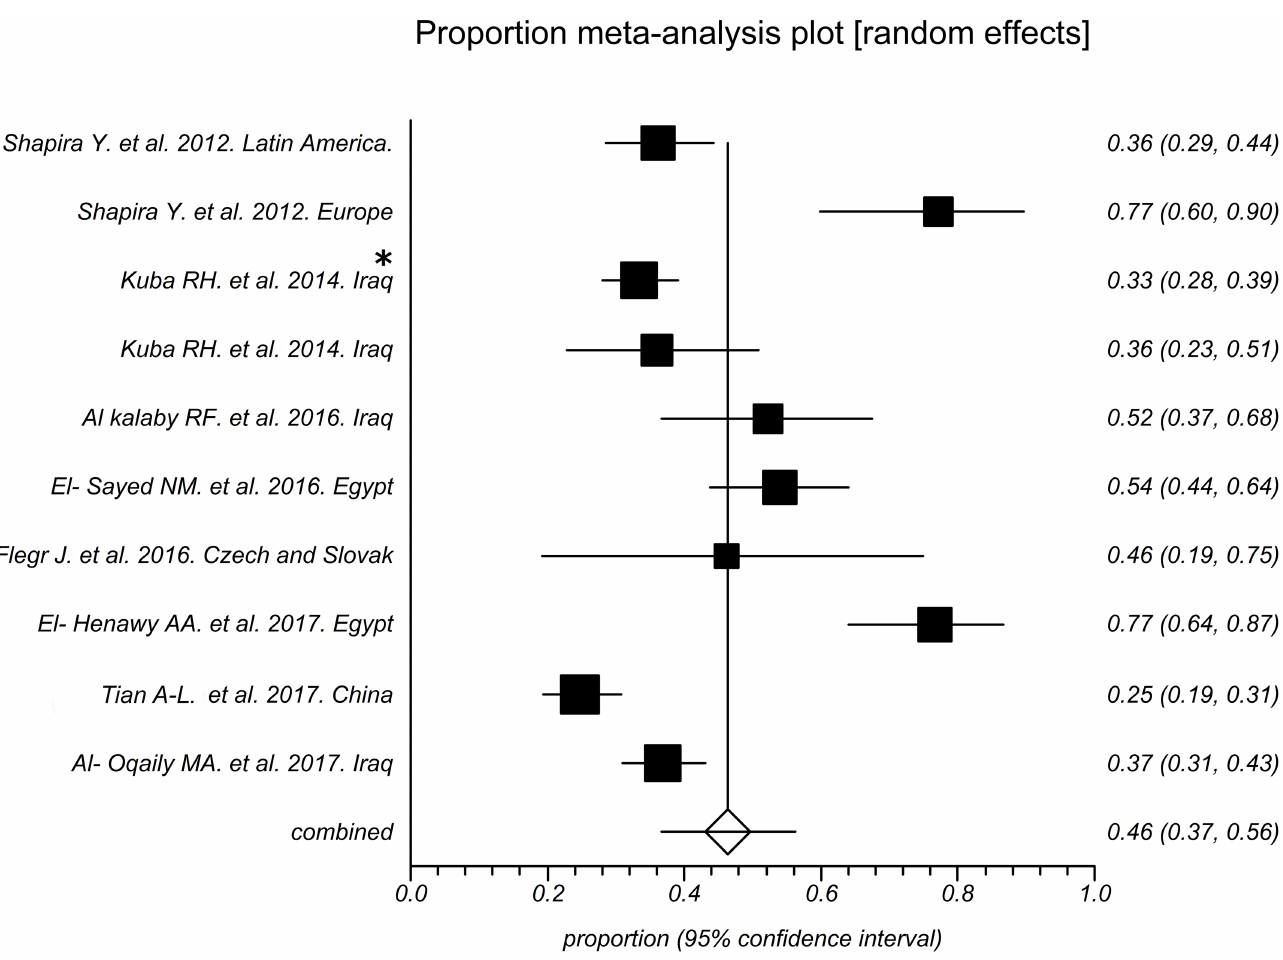
PLOS NeglectedTropical Diseases | https://doi.org/10.1371/journal.pntd.0006545 June 5,